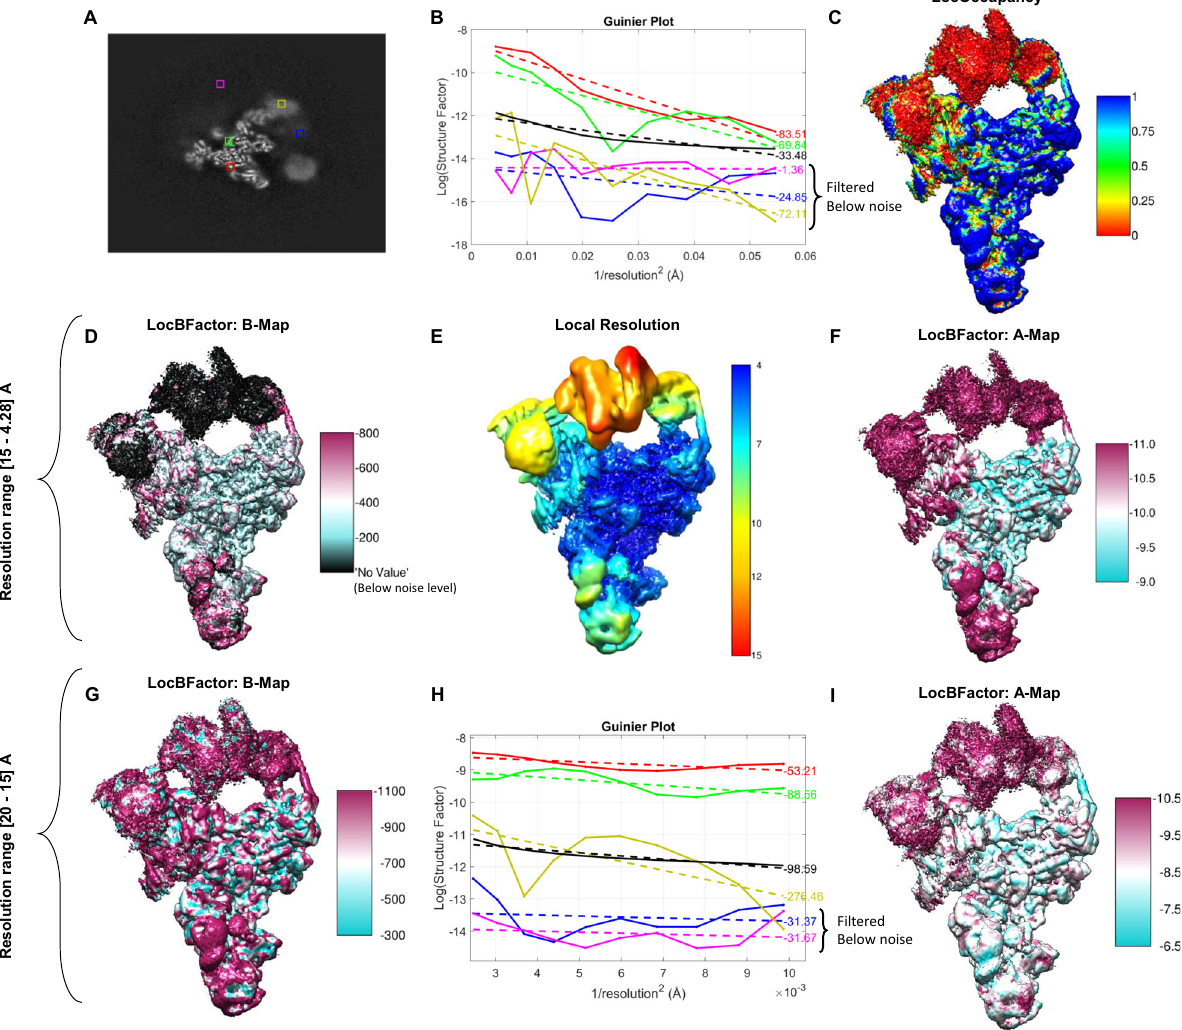
Fig. 2 Results obtained by LocBFactor and LocOccupancy for the Saccharomyces cerevisiae pre-catalytic B complex spliceosome sample. A Central slice along Z axis of the obtained unsharpened map using EMPIAR 10180 single particles. Coloured squares mark parts of the map corresponding to clear spliceosome densities (green and red), fl exible and low-resolution spliceosomal regions (yellow and blue) and background (magenta). B Guinier plots at map points indicated in the coloured squares using a resolution range of [15 – 4.28] Å. Solid lines represent SNR-weighted values of the logarithm of structure factor amplitudes, while discontinued lines show the fi tted lines. C Spliceosome map coloured with the obtained occupancy map by LocOccupancy. The occupancy ranges from 0 (red colour) to 1 (blue colour), indicating no macromolecular density and full occupancy, respectively. D Spliceosome map coloured with the B -factor map to be used for sharpening (slope of the local Guinier plot multiplied by 4) obtained by LocBFactor using a resolution range of [15 – 4.28] Å. The local B -factor values in the fi gure range approximately between − 800 and − 200 Å 2 . In this fi gure, noise B -factors ( B -factors obtained from amplitudes below the noise level for the used resolution range) are fi ltered out and appear with black colour. E Local resolution map obtained by Resmap approach. The local resolution ranges between 4 (blue colour) and 15 Å (red colour). F Spliceosome map coloured with the obtained A map (local values of the logarithm of structure factor amplitudes at 15 Å). The values range between − 11.0 (magenta colour) and − 9.0 (cyan colour) approximately. G Spliceosome map coloured with the B -factor map ( B -map) obtained by LocBFactor using a resolution range of [20 – 15] Å. The B - factor values range between − 1100 (magenta colour) and − 300 (cyan colour) approximately. H Guinier plots at map points indicated in the coloured squares using a resolution range of [20 – 15] Å. Solid lines represent SNR-weighted values of the logarithm of structure factor amplitudes, while discontinued lines show the fi tted lines. I Spliceosome map coloured with the obtained A map (local values of the logarithm of structure factor amplitudes at 20 Å). The values range between − 10.5 (magenta colour) and − 6.5 (cyan colour)